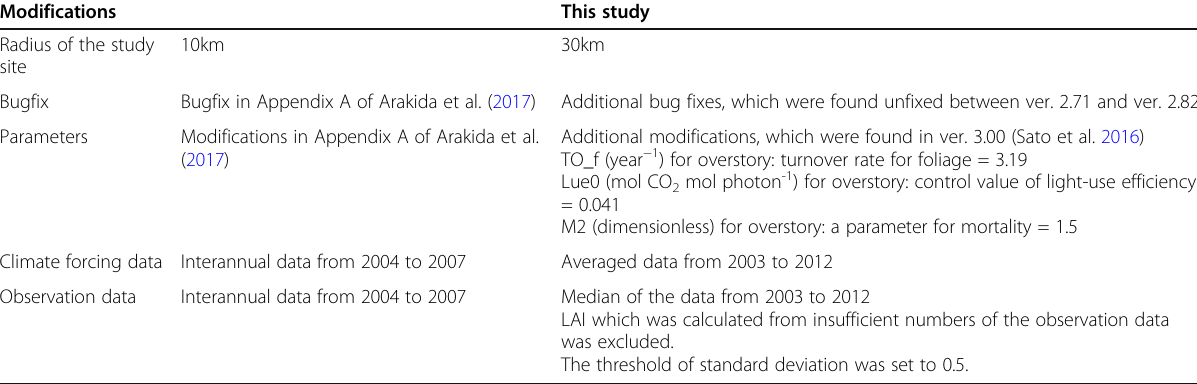
Table 1 Modifications to the data assimilation (DA) system of Arakida et al.